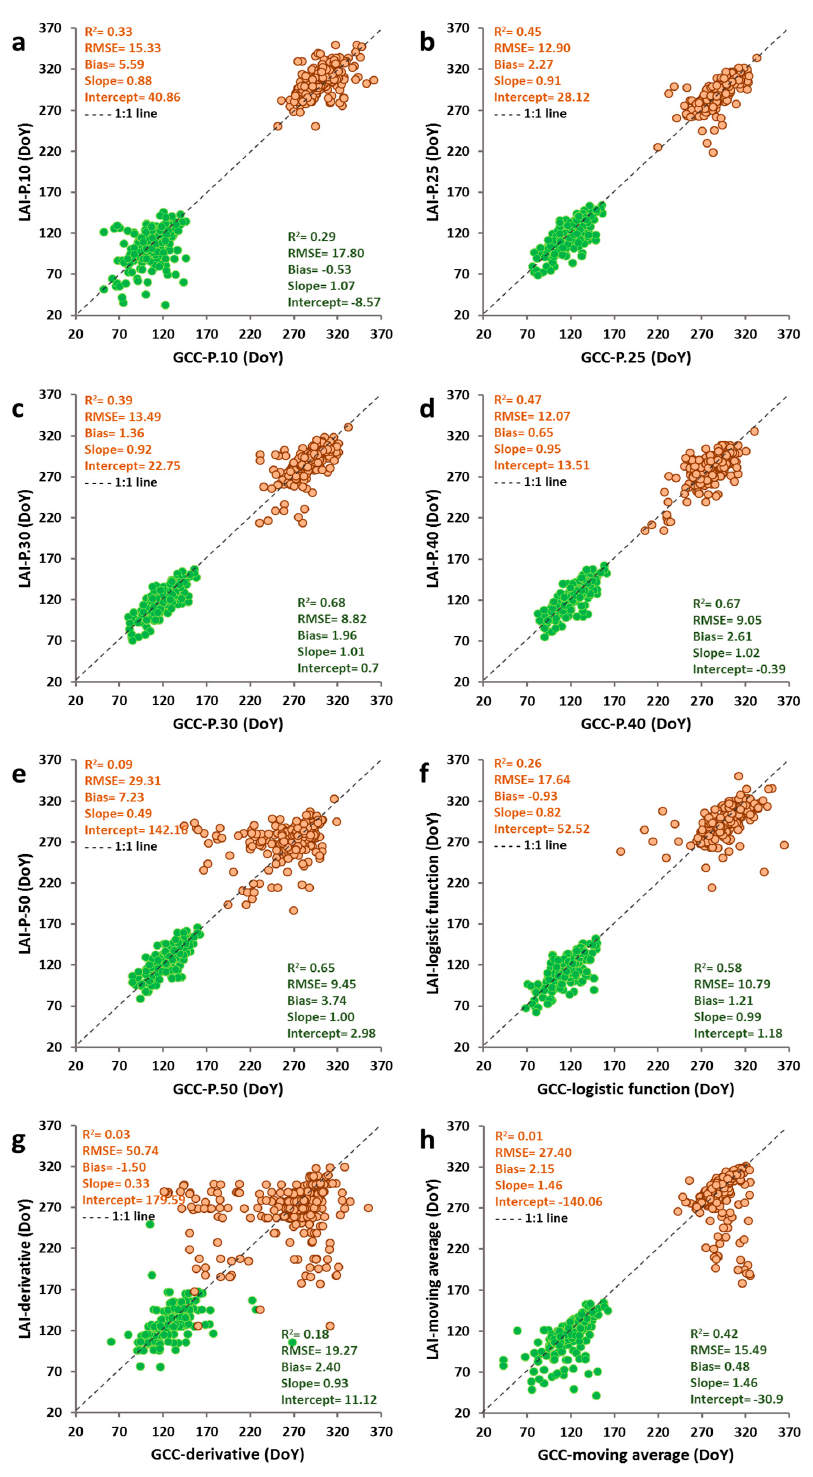
Figure 4. Scatterplots for SoS (in green) and EoS (in orange) estimated from CGLS LAI V2 and PhenoCam GCC time series by the threshold (10th ( a ), 25th ( b ), 30th ( c ), 40th ( d ) and 50th ( e ) percentiles of LAI amplitude), logistic-function ( f ), derivative ( g ) and moving-average ( h ) methods. Statistics of the comparison are presented in Table 2.